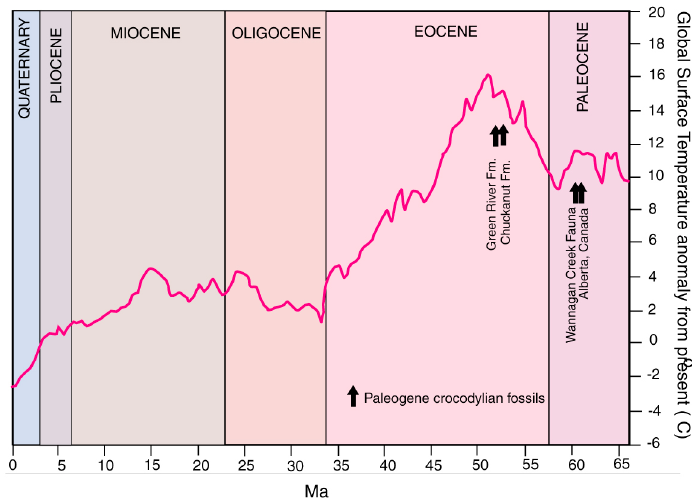
Figure 19. Mean global surface temperatures during the Cenozoic, and age of Paleogene Crocodylian fossils from North America. Paleoclimate data adapted from [67,68].